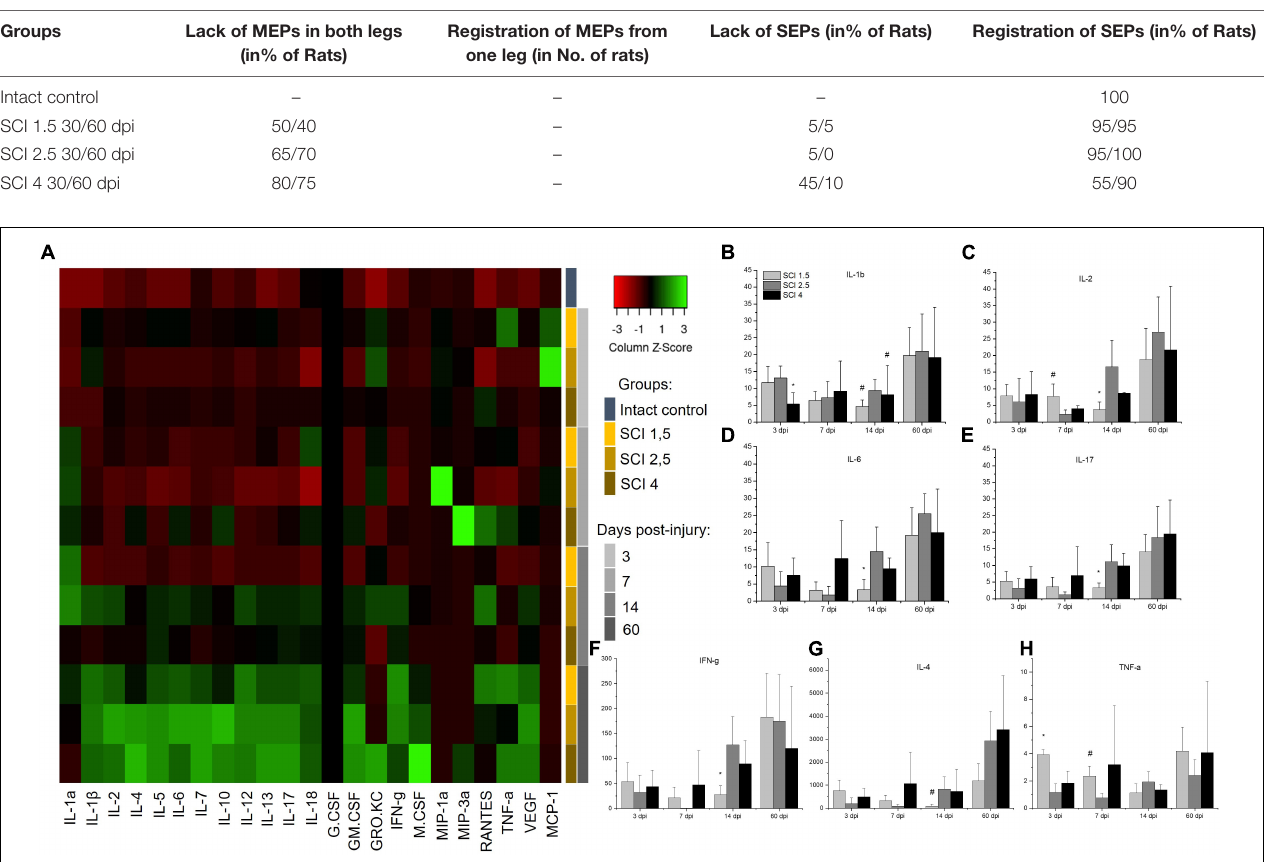
FIGURE 3 | Analysis of the cytokine profile of contused and intact spinal cords. Heat map analysis of the cytokine profile (color keys) in the spinal cords of experimental groups and intact controls (A) . Concentration (Y axis, pg/ml) of IL-1b, IL-2, IL-6, IL-17, IFN-g, IL-4, and TNF-a at days 3, 7, 14, and 60 after spinal cord injury of mild (SCI 1.5), moderate (SCI 2.5), and severe (SCI 4) severities was analyzed (B–H) , n = 7 in each group and each of the above dpi. The cytokine expression levels in the intact spinal cord were considered as 1. *p < 0.05 as compared with all investigated groups; # p < 0.05 as compared with the SCI 1.5 group, one-way ANOVA, followed by a Tukey’s post hoc